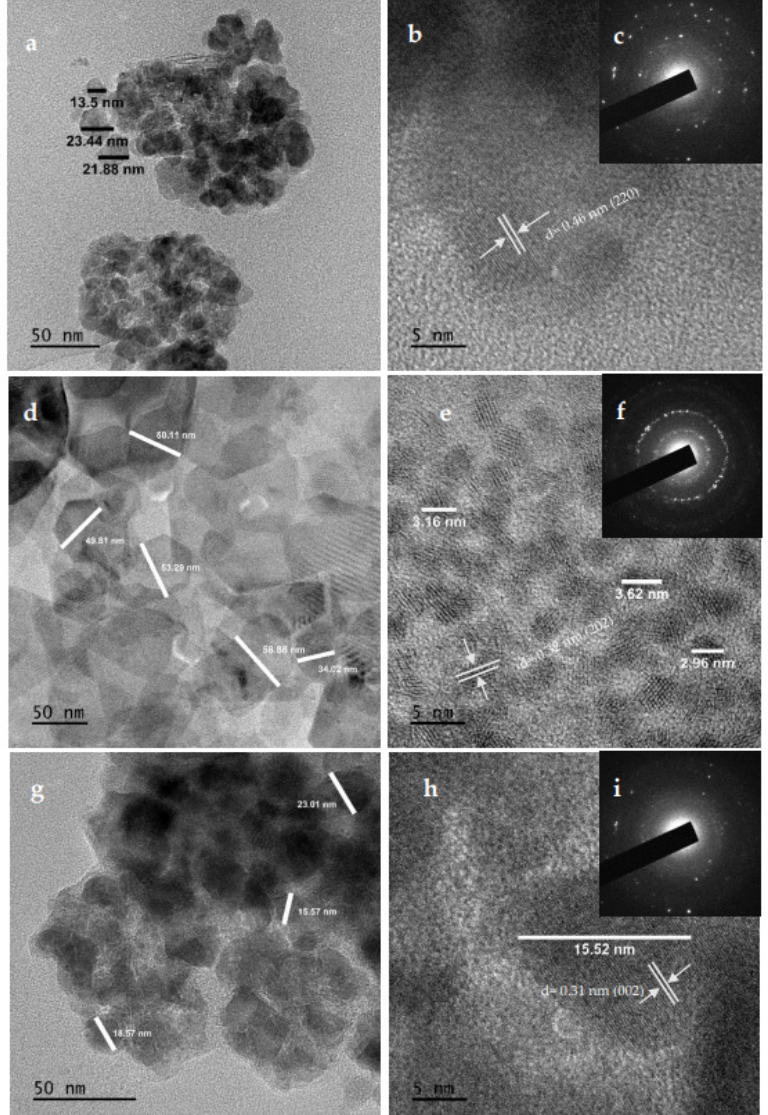
Figure 6. HRTEM and SAED images of MnS_1 ( a,b ) and ( c ), MnS_2 ( d , e ) and ( f ) and MnS_3 ( g , h ) and ( i )